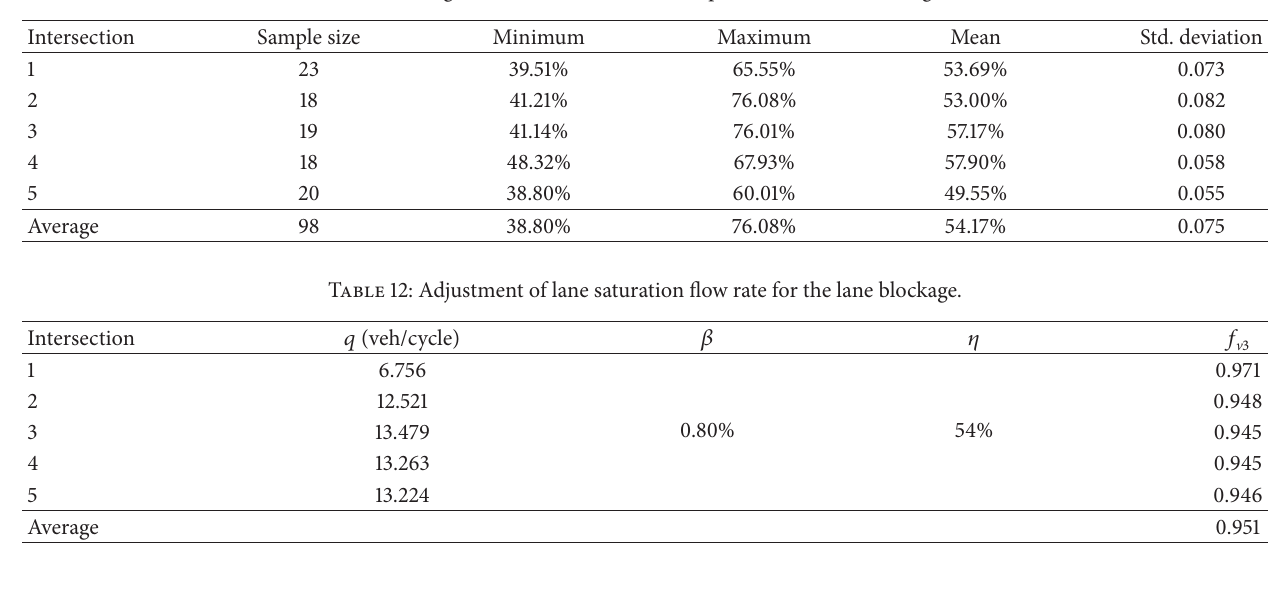
Table 11: Percentages of saturation flow rate drops when the lane blockage occurs.